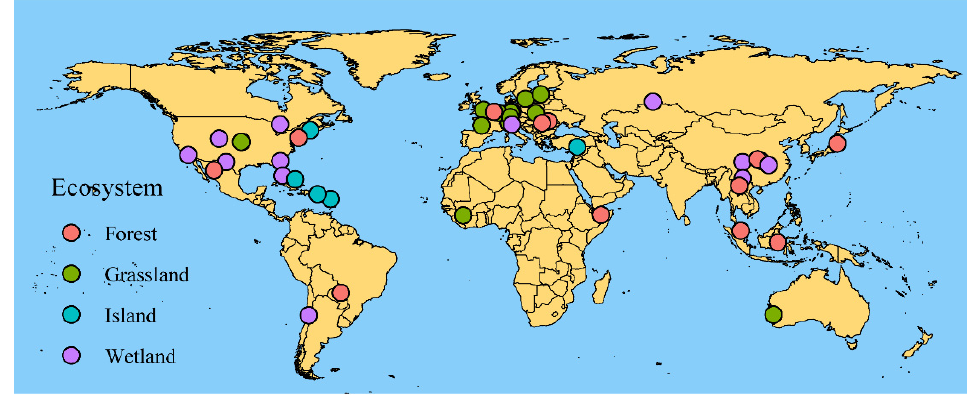
Figure 1. Geographic locations of the 39 studies included in the meta-analysis. Different colors indicate different ecosystem types.